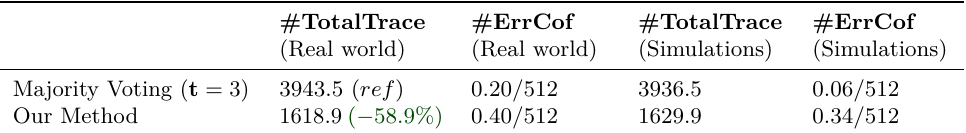
Table 9: Comparison between majority-voting and our proposed method for full-key recovery in real-world experiments and